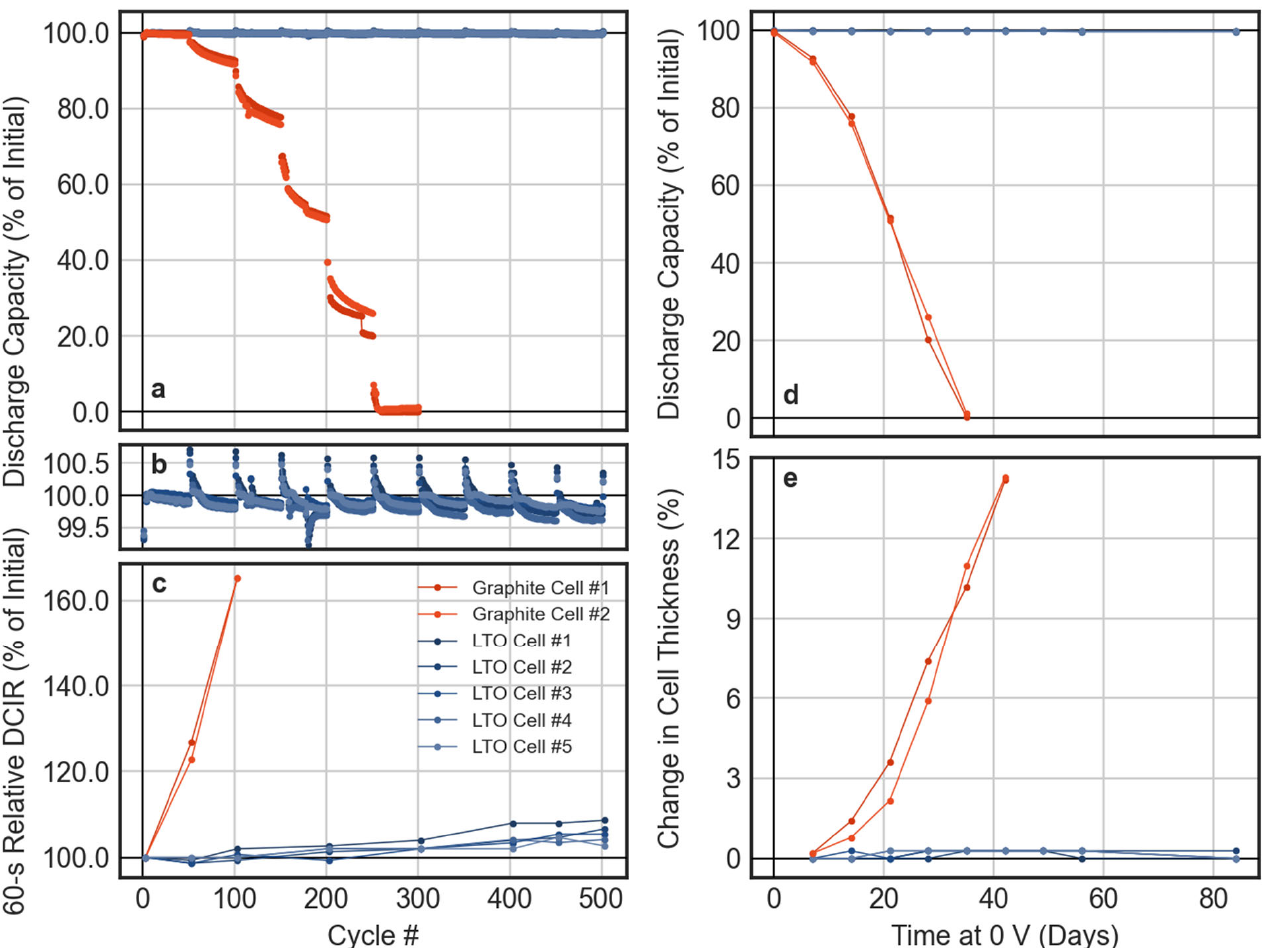
Figure 3. Overdischarge cycling performance data. The left-hand column shows the standard cycle discharge capacity ( a,b ) and DCIR @ 50% SOC ( c ) vs. the number of cycles for overdischarged cells. Right-hand column: ( d ) the final discharge capacity prior to each overdischarge and ( e ) DCIR @ 50% SOC vs. total time spent at 0 V.